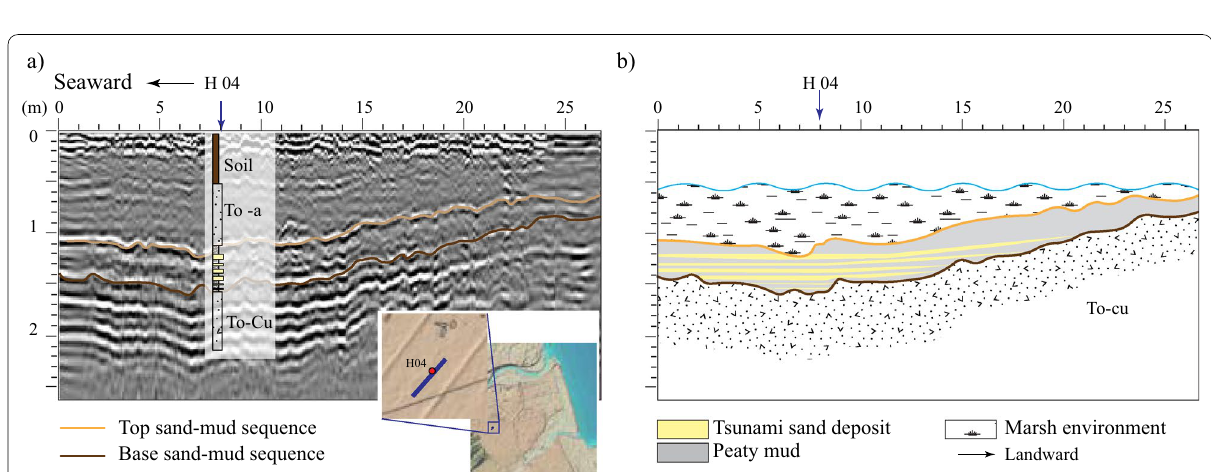
Fig. 14 Paleosedimentary environment interpretation for the base of the peaty‑mud sequence. a Ground penetrating radar image obtained around H04 sampling area. Strong reflectors display the top and base of the sand/peaty‑mud sequence. b Interpreted paleo environment before the deposition of T1, T2 and T3. It was contructed by using diatom results, sedimentary characteristics, and GPR